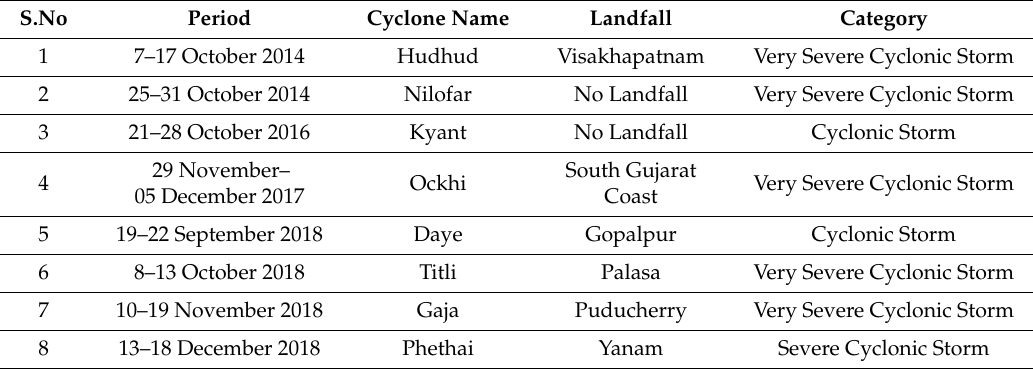
Figure 1. Best tracks of tropical cyclones (TCs) considered in the present study. Table 1. Details of the study of tropical cyclones (TCs).